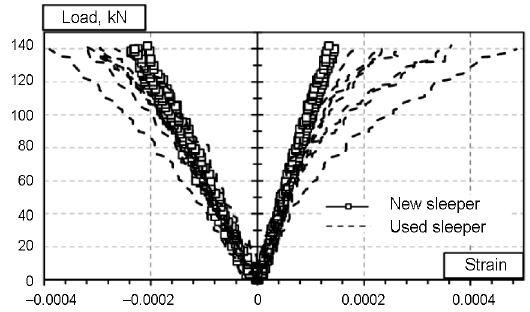
Fig. 9. Load-strain relationships of concrete at rail seat section